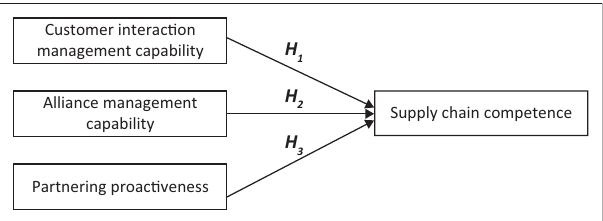
FIG URE 1: Conceptual